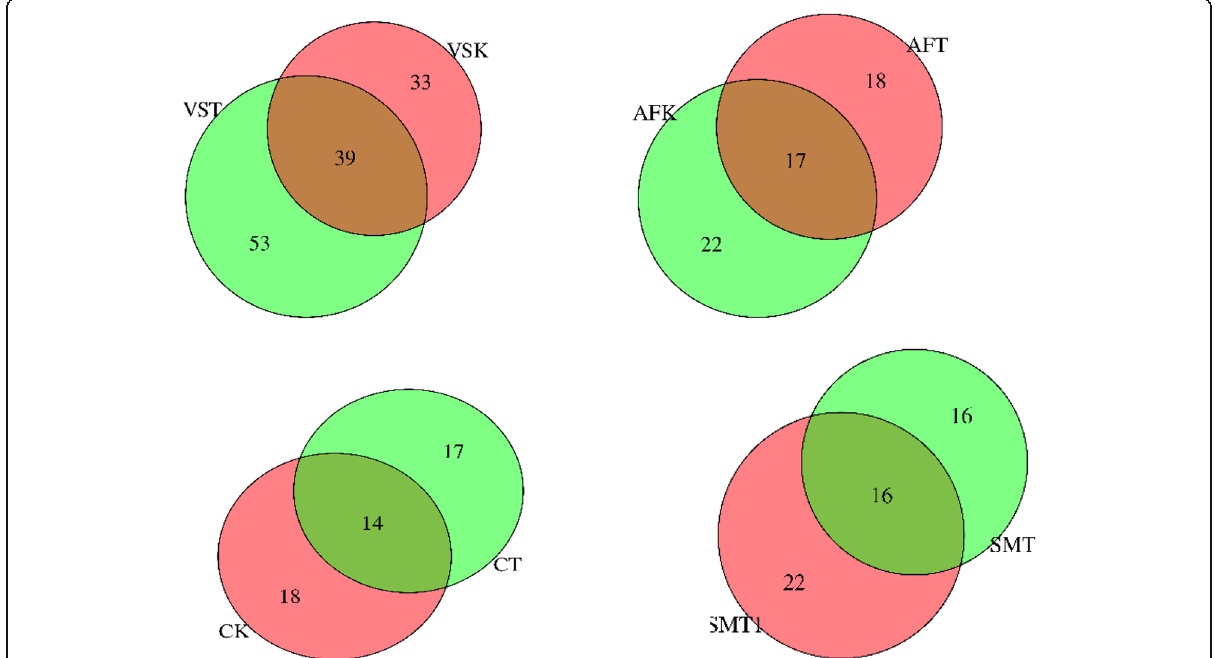
Fig. 7 Shared operational taxonomic units (OTUs) among vended foods in Embu Town and Kangaru Market. Key: African Sausage Kangaru (AFK), African Sausage